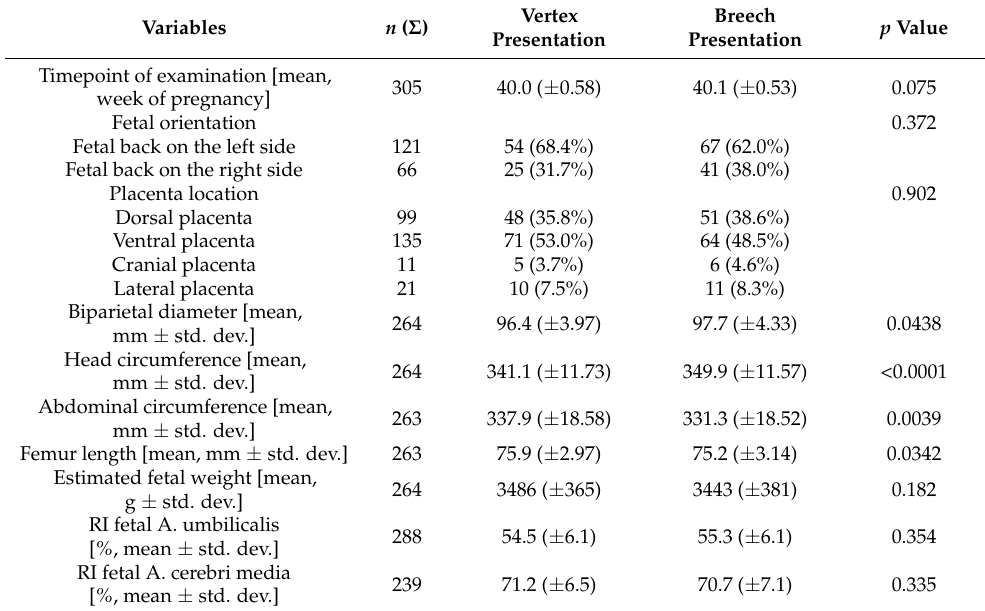
Table 2. Ultrasound findings and measurements of Doppler sonography and biometric fetal weight estimation in vertex presentation and breech presentation group.